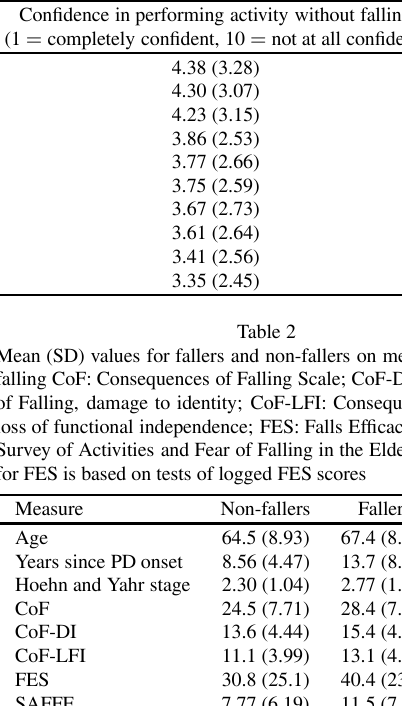
Mean (SD) scores on the Falls Ef fi cacy Scale. Valid N ranged from 121 to 125 Activity Simple shopping